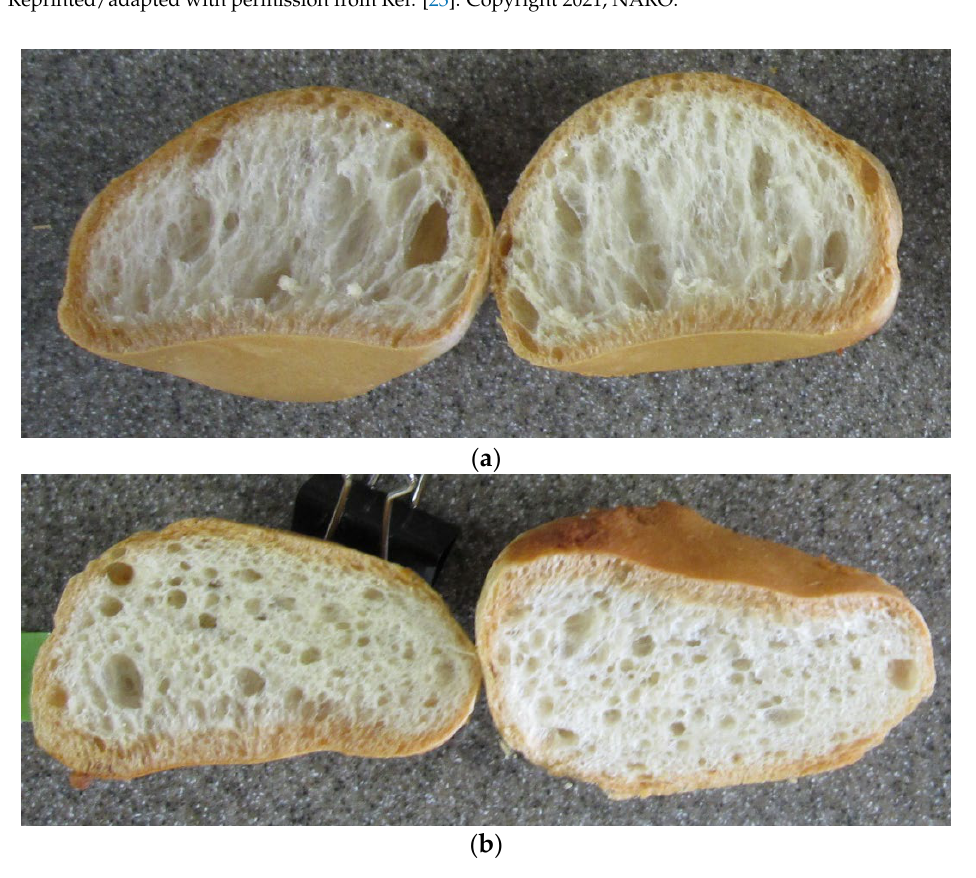
Figure 4. Half-cut end surface of the bread made of soy protein/raw egg white. ( a ) No starch and ( b ) cornstarch (2.5 g) were added to the dough, respectively. Reprinted/adapted with permission from Ref. [23]. Copyright 2021, NARO.